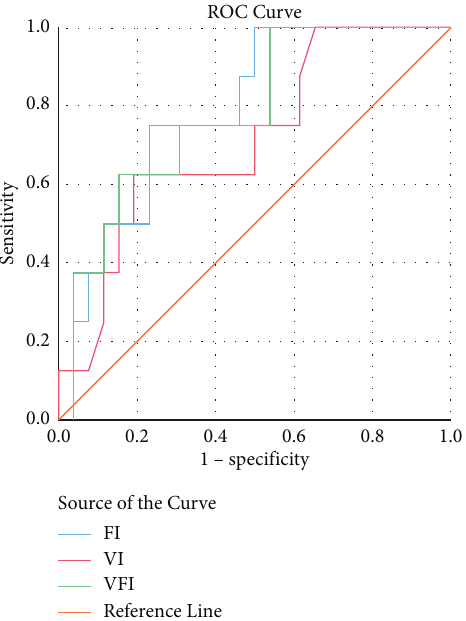
Figure 3: ROC cure of vascularity indexes on massive blood